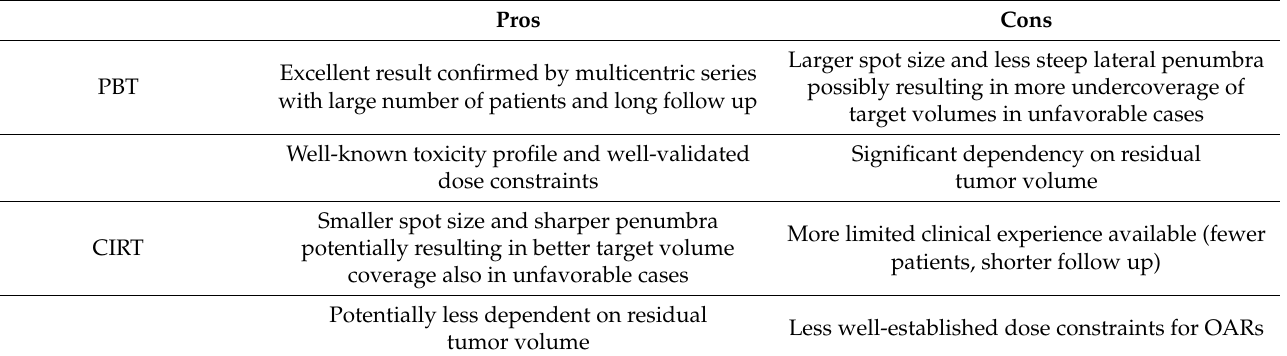
Table 5. Relative advantages and disadvantages of PBT and